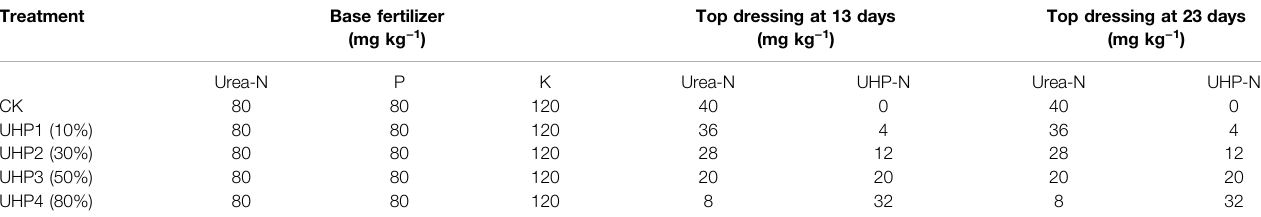
TABLE 1 | Fertilizer application amounts and times. Treatment